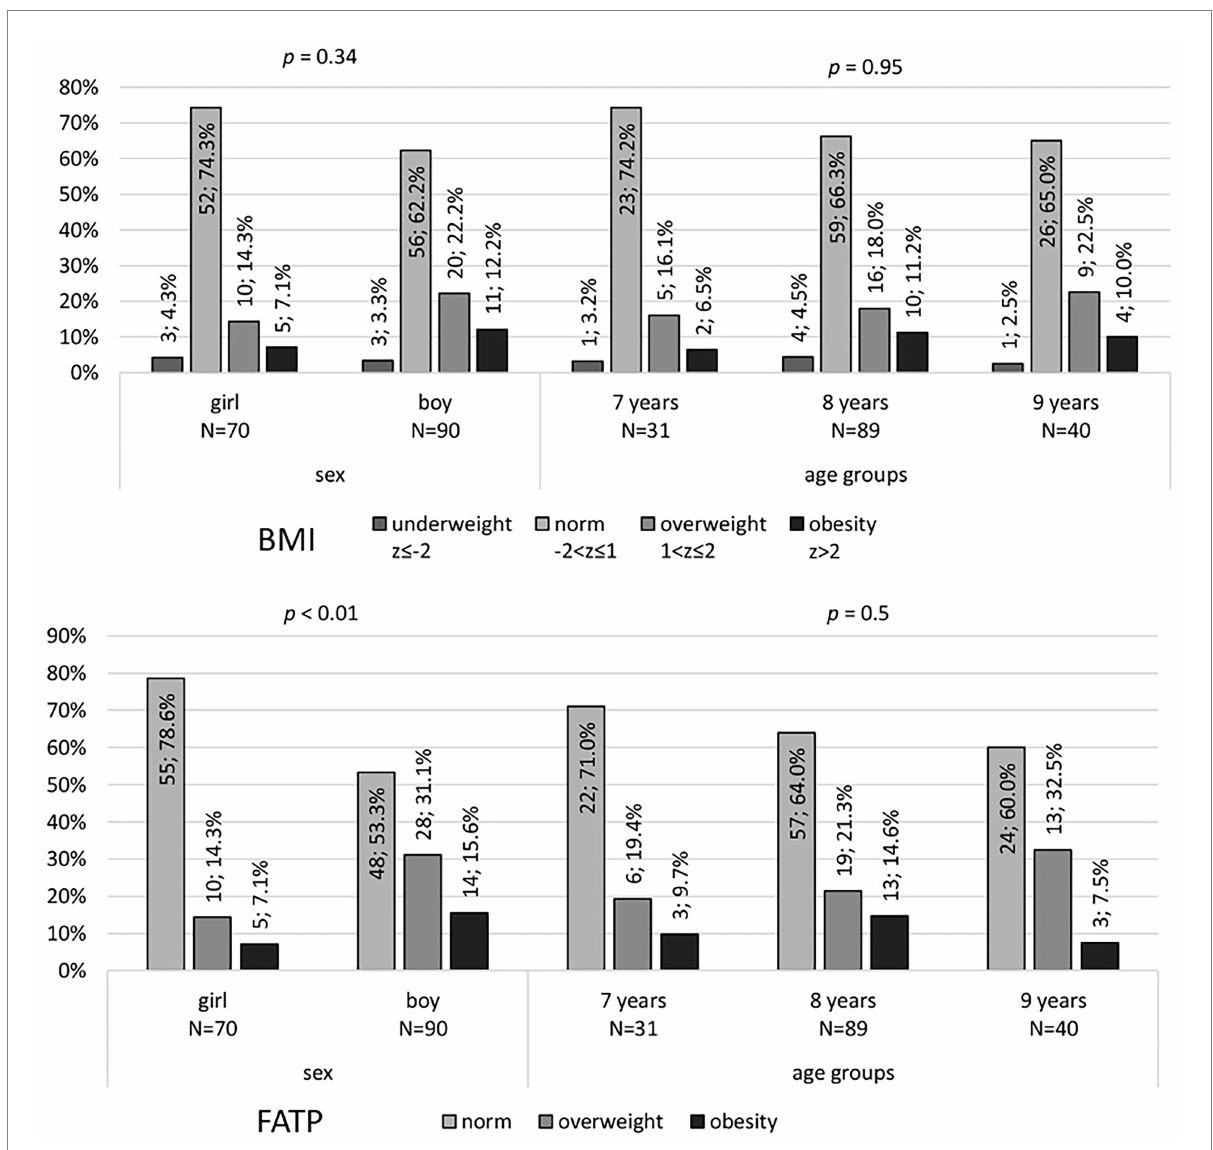
FIGURE 1 Assessment of the percentage of Body Mass Index (BMI acc. WHO standardized scale) and body fat (FATP acc. Tanita scale) including BioData. Data presented as a number of children n; percentage